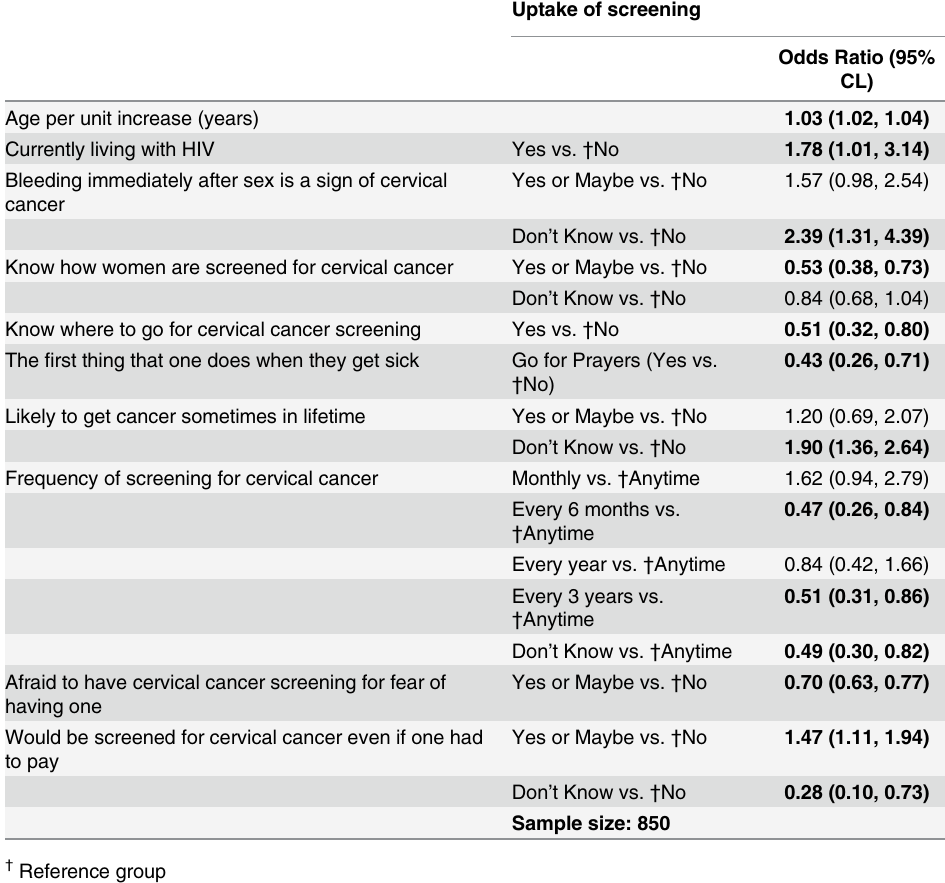
Table 4. Factors associated with uptake of cervical cancer screening in multivariate